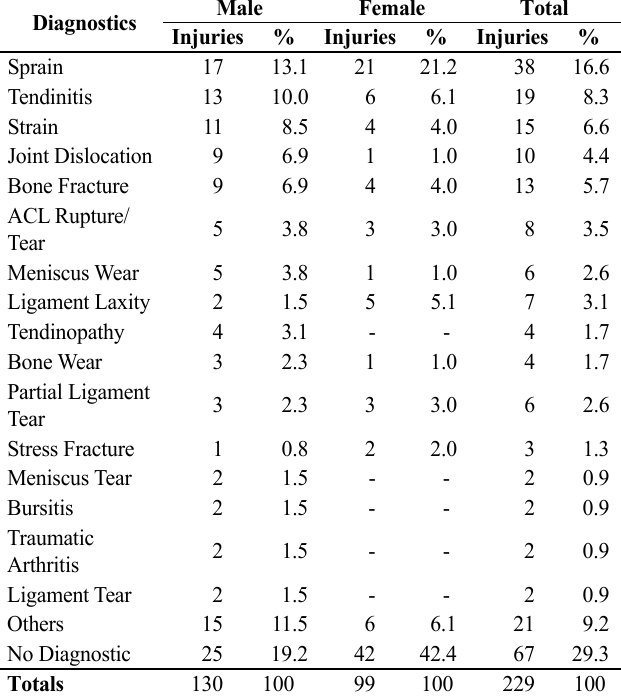
Table 3. Injury diagnostics reported by handball athletes (male, female, and both genders